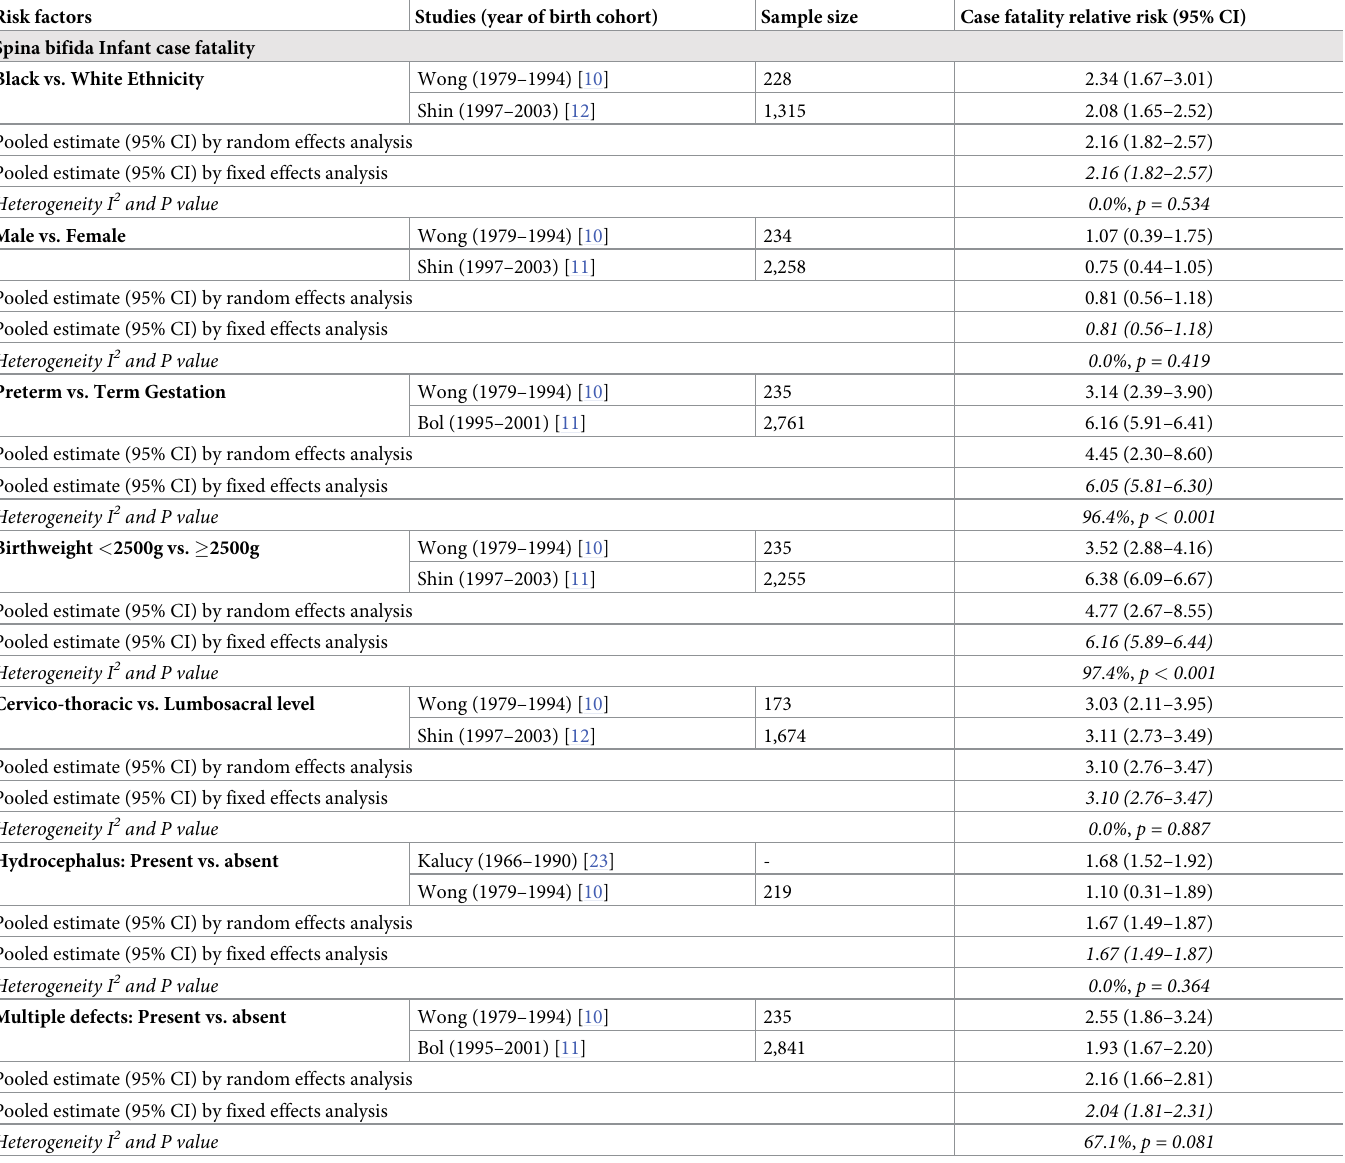
Table 4. Risk factors for spina bifida infant case fatality (relative risks